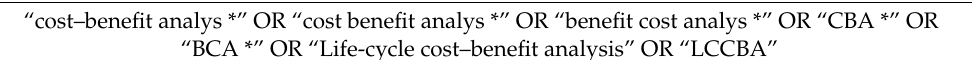
Table A1. Literature search syntax used in WoS and Scopus databases. WoS: “Topic” field Scopus: “TITLE-ABS-KEY”